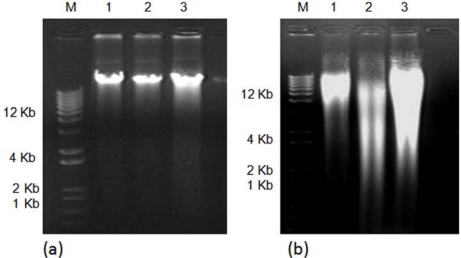
Analysis of Oncideres albomarginata chamela-DNA digested with different restriction enzymes and separated by 1% agarose gel electrophoresis. (a) Genomic DNA isolated with the CTAB-method, and (b) Genomic DNA isolated with the CTAB-PVP method. For both (a) and (b), Lane M, DNA size marker (1 Kb plus DNA ladder; Invitrogen, Carlsbad, CA, USA); Lane 1, restriction digestion with XbaI; Lane 2, restriction digestion with NotI; Lane 3, restriction digestion with EcoRI.